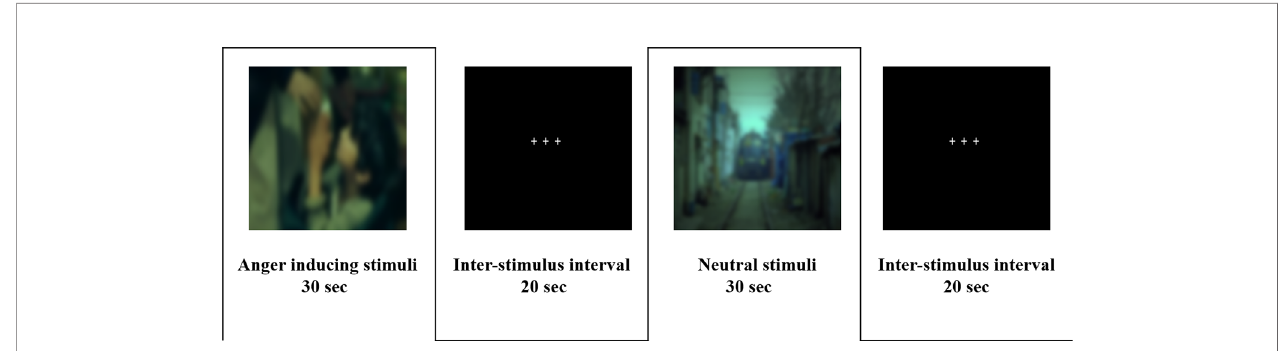
FIGURE 1 | Experimental paradigm for functional magnetic resonance